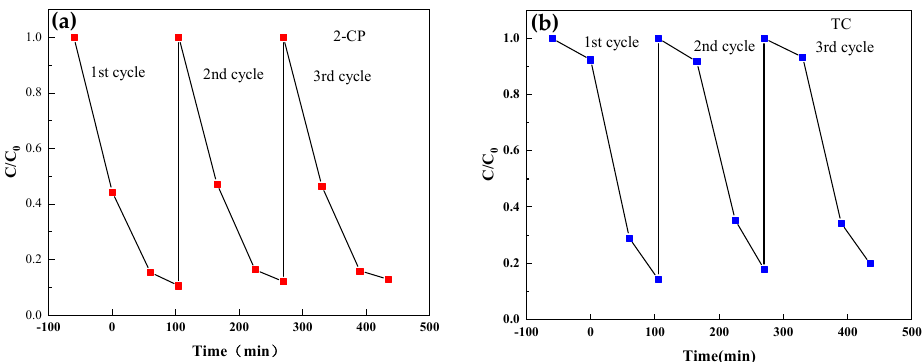
Figure 13. Photo-stability and recyclability of the optimized catalyst. ( a ) Application to 2-CP de- gradability reusability trials. ( b ) Application to TC degradability reusability trials.